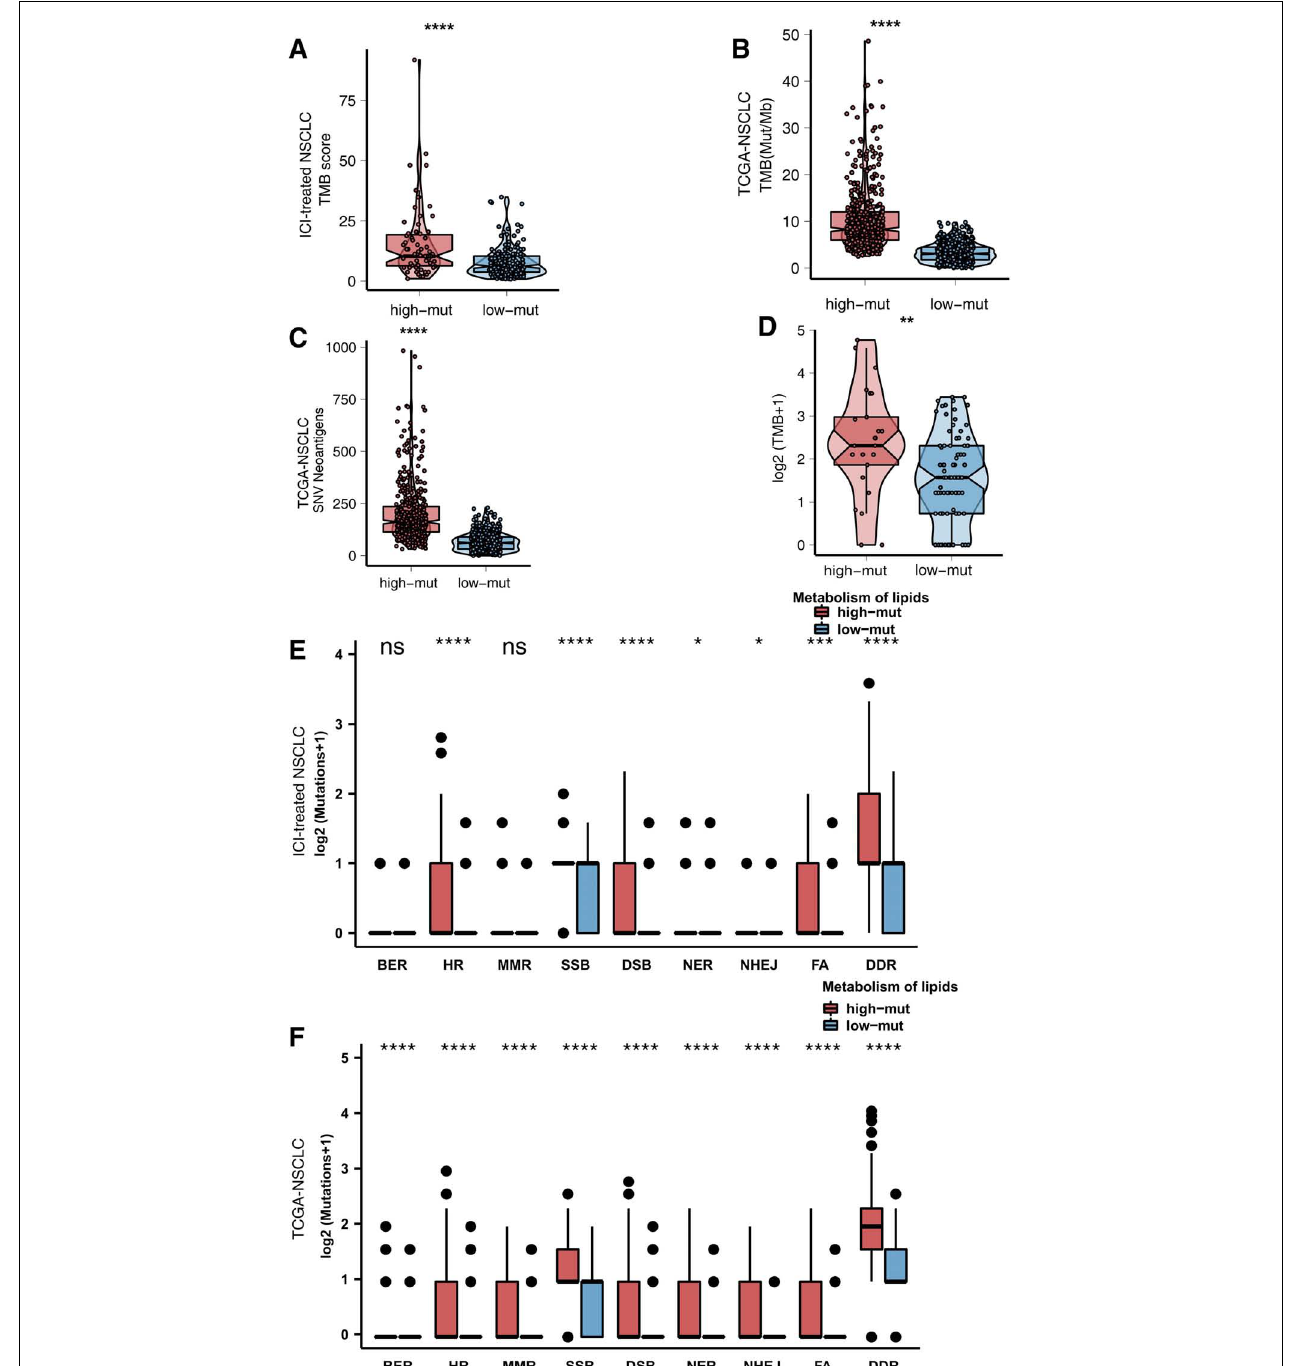
FIGURE 4 | (A) Comparison of TMB scores between the high and low mutation groups in the ICI-treated cohort (Rizvi et al., 2018). (B) Comparison of TMB between the high and low mutation groups in the TCGA cohort. (C) Comparison of TMB between the high and low mutation groups in the Local-NSCLC cohort. (D) Comparison of NAL between the high and low mutation groups in the TCGA cohort. (E) Comparison of DNA damage-related gene set alterations between the high and low mutation groups in the ICI-treated cohort (Rizvi et al., 2018). (F) Comparison of DNA damage-related gene set alterations between the high and low mutation groups in the TCGA